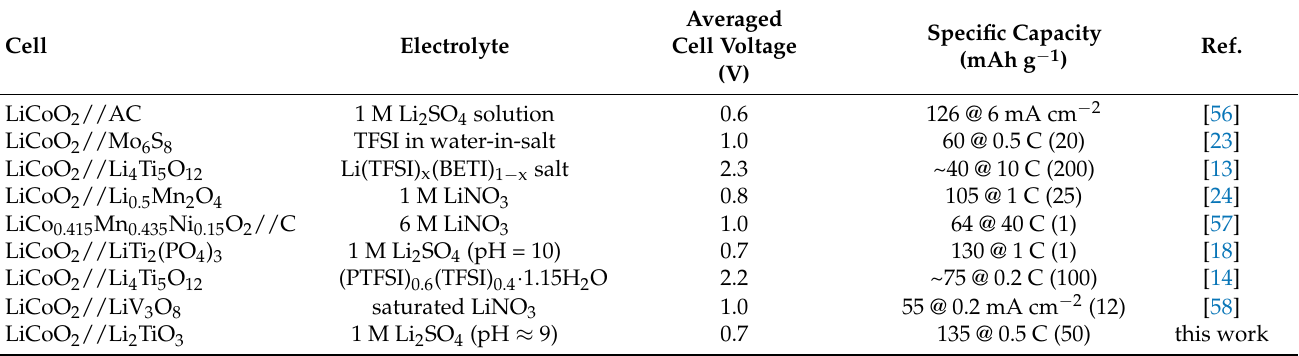
Table 1. Comparison of the electrochemical performance of various LCO-based aqueous cells. Number of cycles are given in